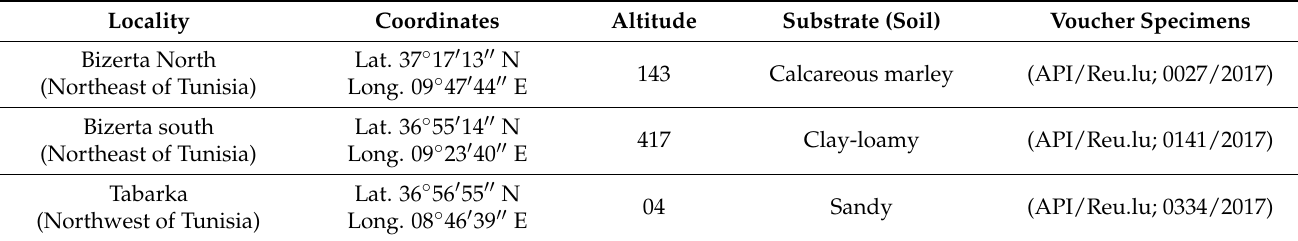
Table 1. Characteristics of sampling sites of Pimpinella lutea harvested during the flowering-fruiting period. Locality Coordinates Altitude Substrate